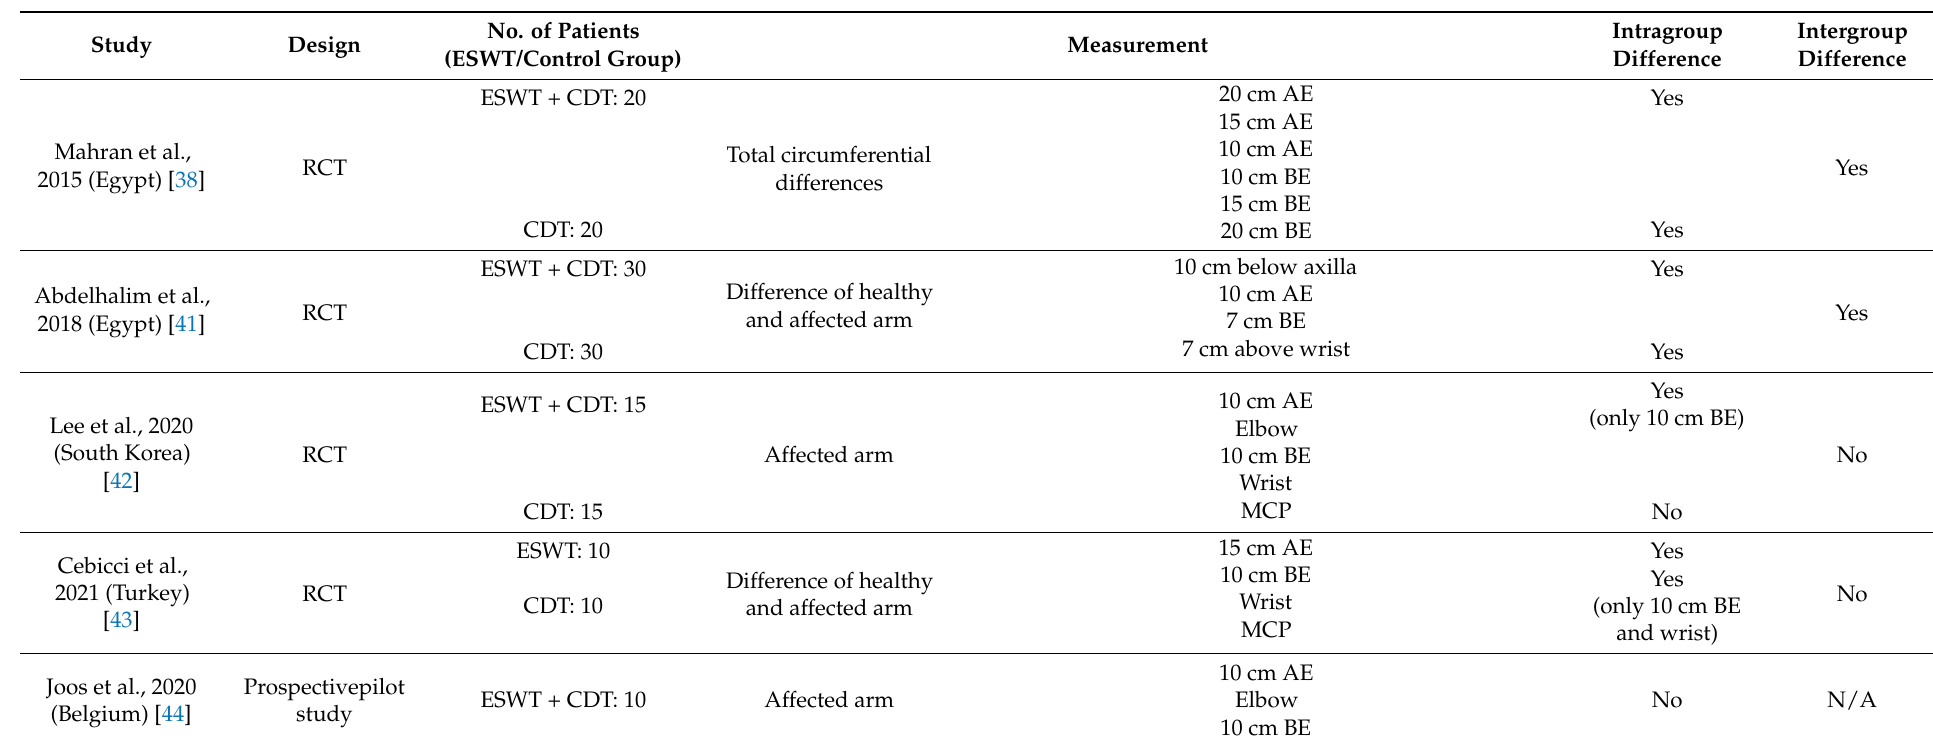
Table 6. Outcome measurements of the arm circumference in included studies for ESWT in